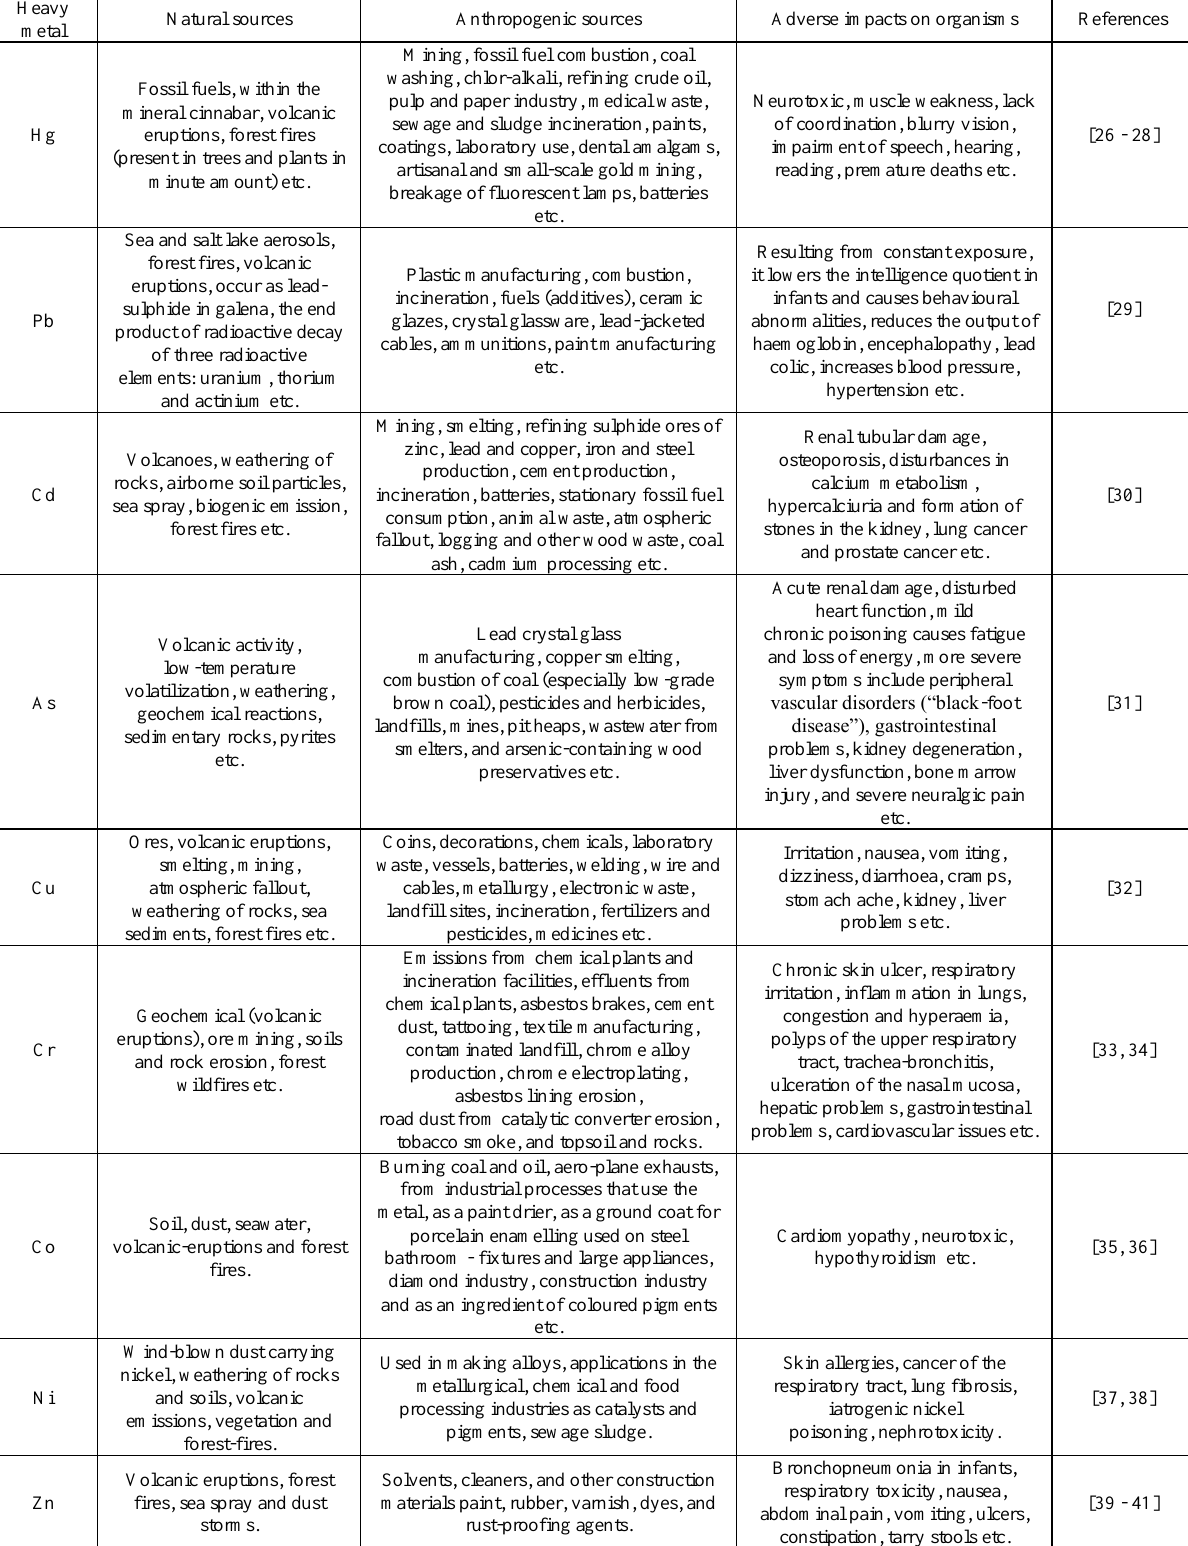
Table 1. Sources of heavy metals and its adverse impact on organisms Heavy